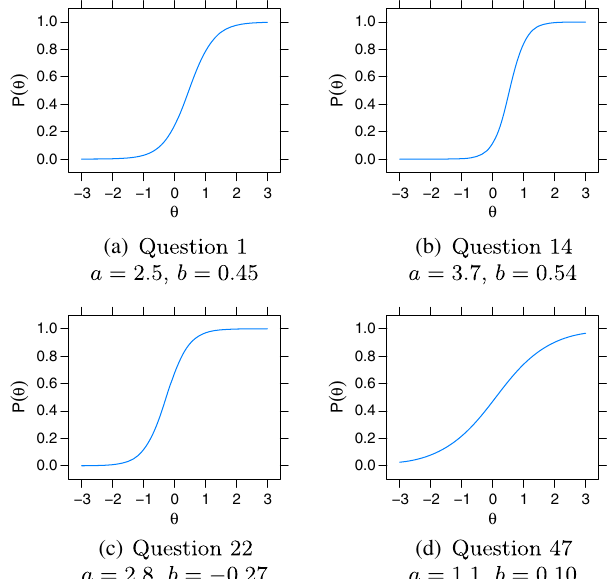
FIG. 1. Item response theory plots for questions 1, 14, 22, and 47: probability of answering correctly as a function of the latent ability parameter θ . The plots help to illustrate the meaning of the discrimination a and difficulty b parameters in the two-parameter logistic (2PL) IRT model shown in Eq.